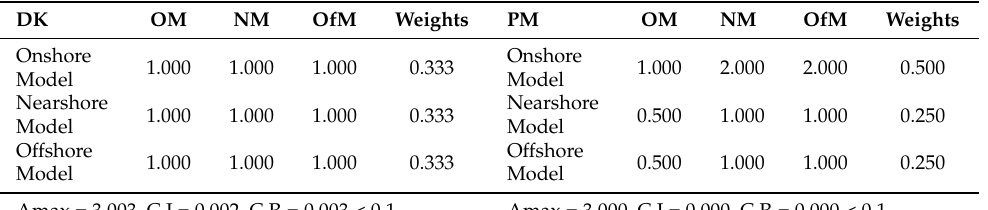
Table 12. Weights of the alternatives with respect to domain knowledge and project management.